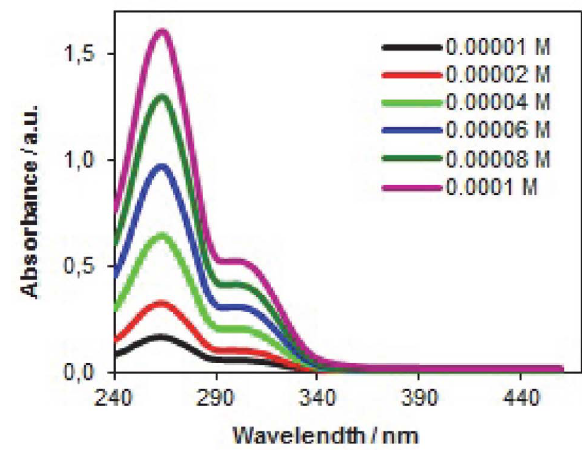
Fig 3. Absorbance spectra of HITO of different molar concentra-